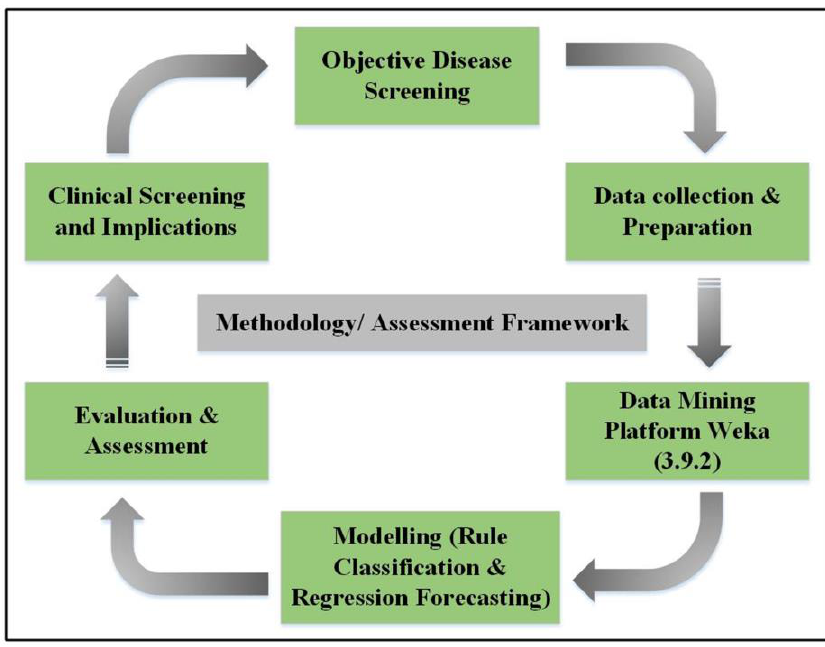
Figure 1. Assessment framework used in this study for clinical implication screening.